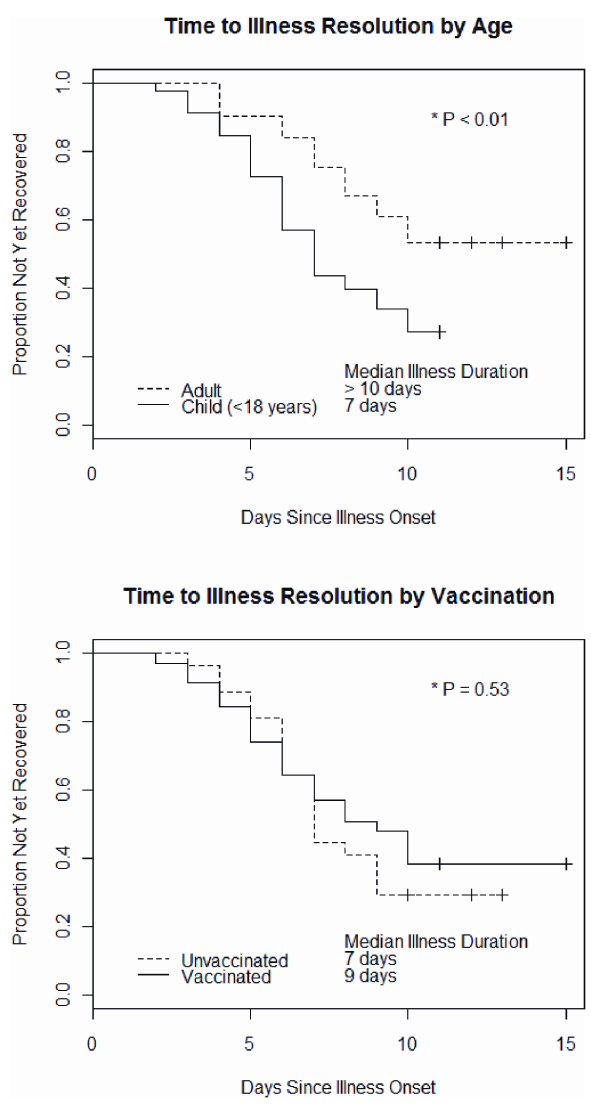
Figure 2. Days from influenza illness onset to resolution of symptoms by age and influenza vaccination: the Household Influenza Vaccine Effectiveness (HIVE) study, Ann Arbor Michigan, 2010-2011 influenza season. Footnotes: + Censored observations. * P -value from Log-Rank test.